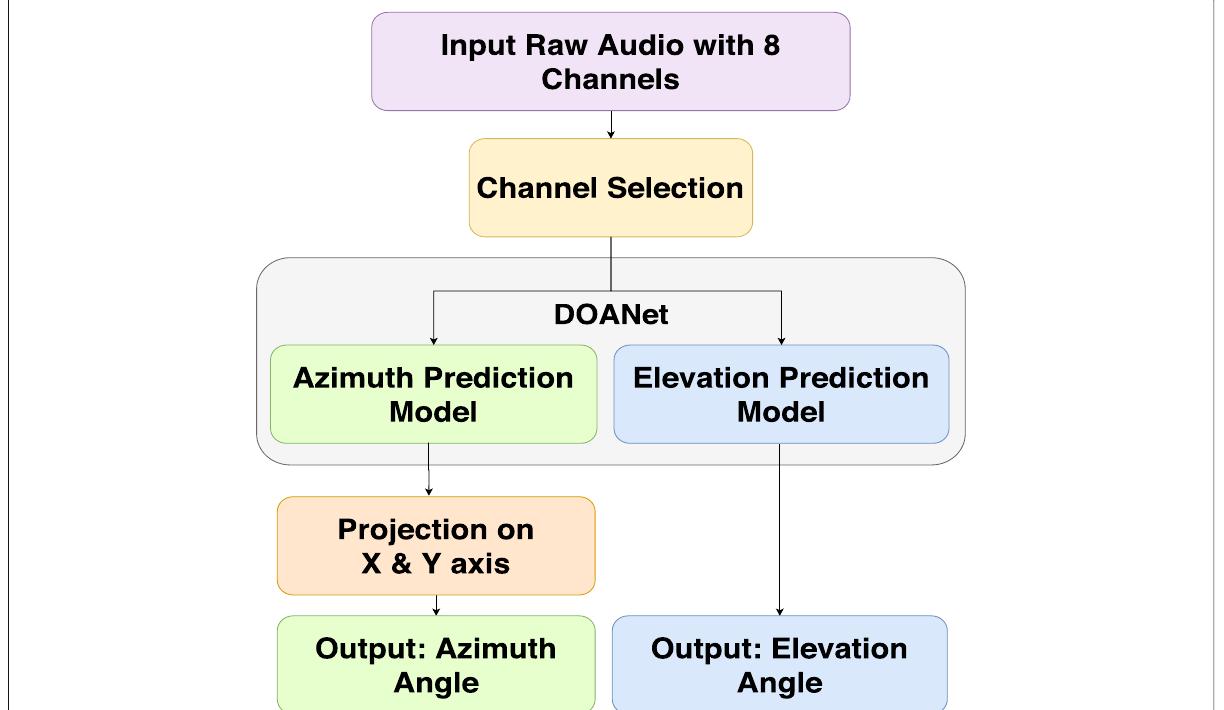
Fig. 5 DOANet-based sound source